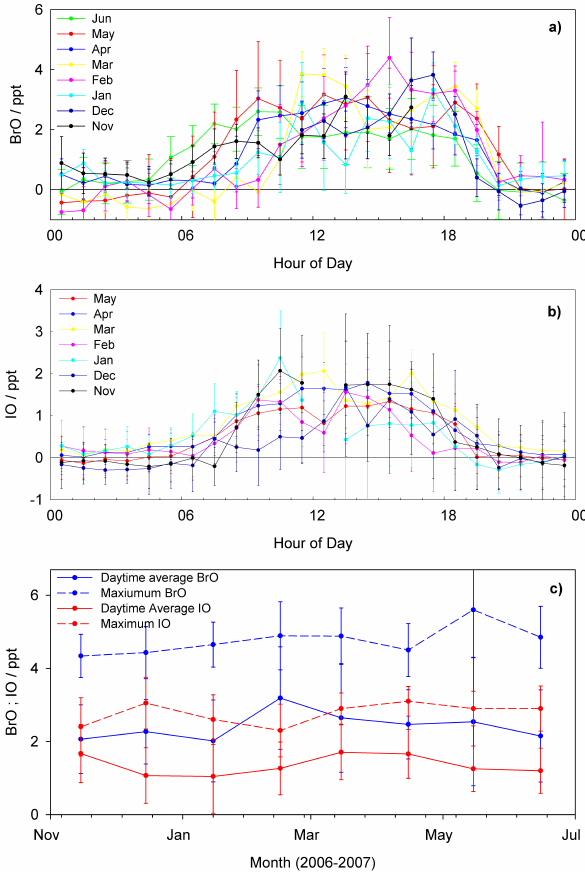
Fig. 1. The monthly averaged diurnal profiles for IO and BrO are shown in panels (a) and (b) . Both radicals show a distinctive top- hat profile with the highest mixing ratios measured between 09:00– 17:00GMT. The average annual profile of IO and BrO along with the highest measured mixing ratio for each month is shown in panel (c) indicating little annual variability. Local noon is at GMT-1. The average detection limits were BrO: 0.5–1.0pmolmol − 1 and IO: 0.3–0.5pmolmol − 1